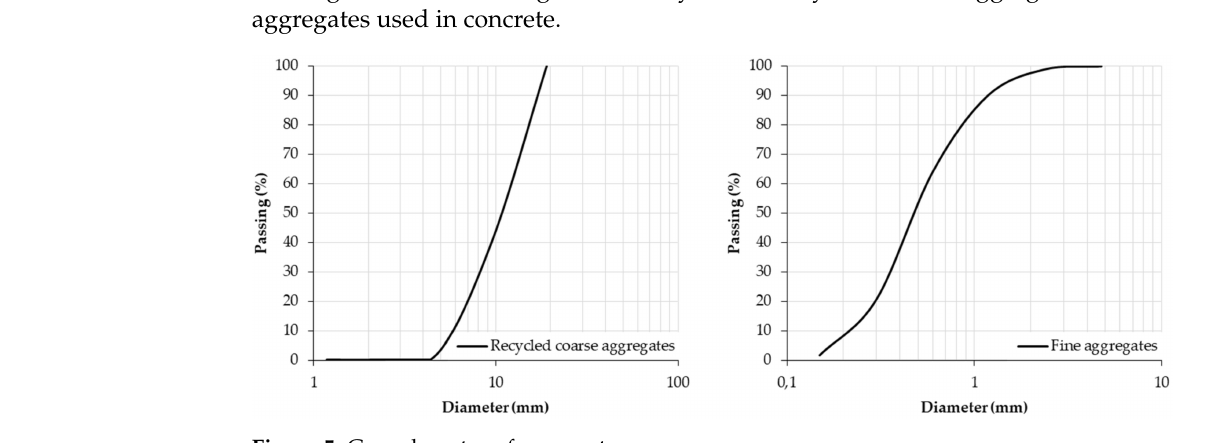
Figure 5. Granulometry of aggregates.